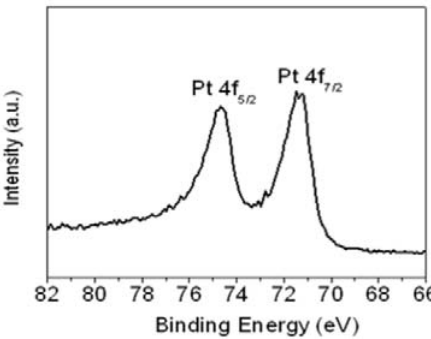
Figure 4. XPS of Pt 4f region for Pt NPs/r-fGO